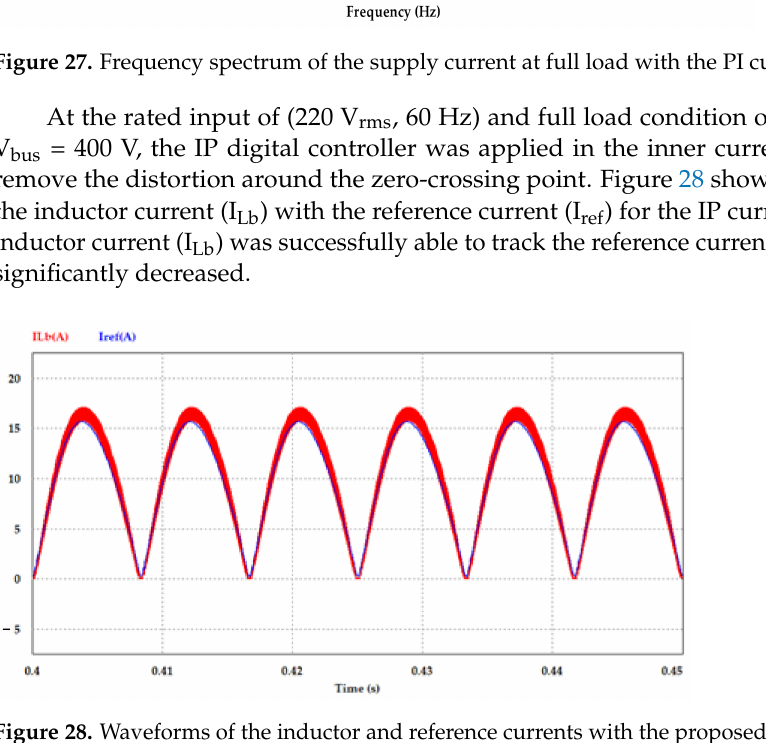
Figure 28. Waveforms of the inductor and reference currents with the proposed IP current controller.